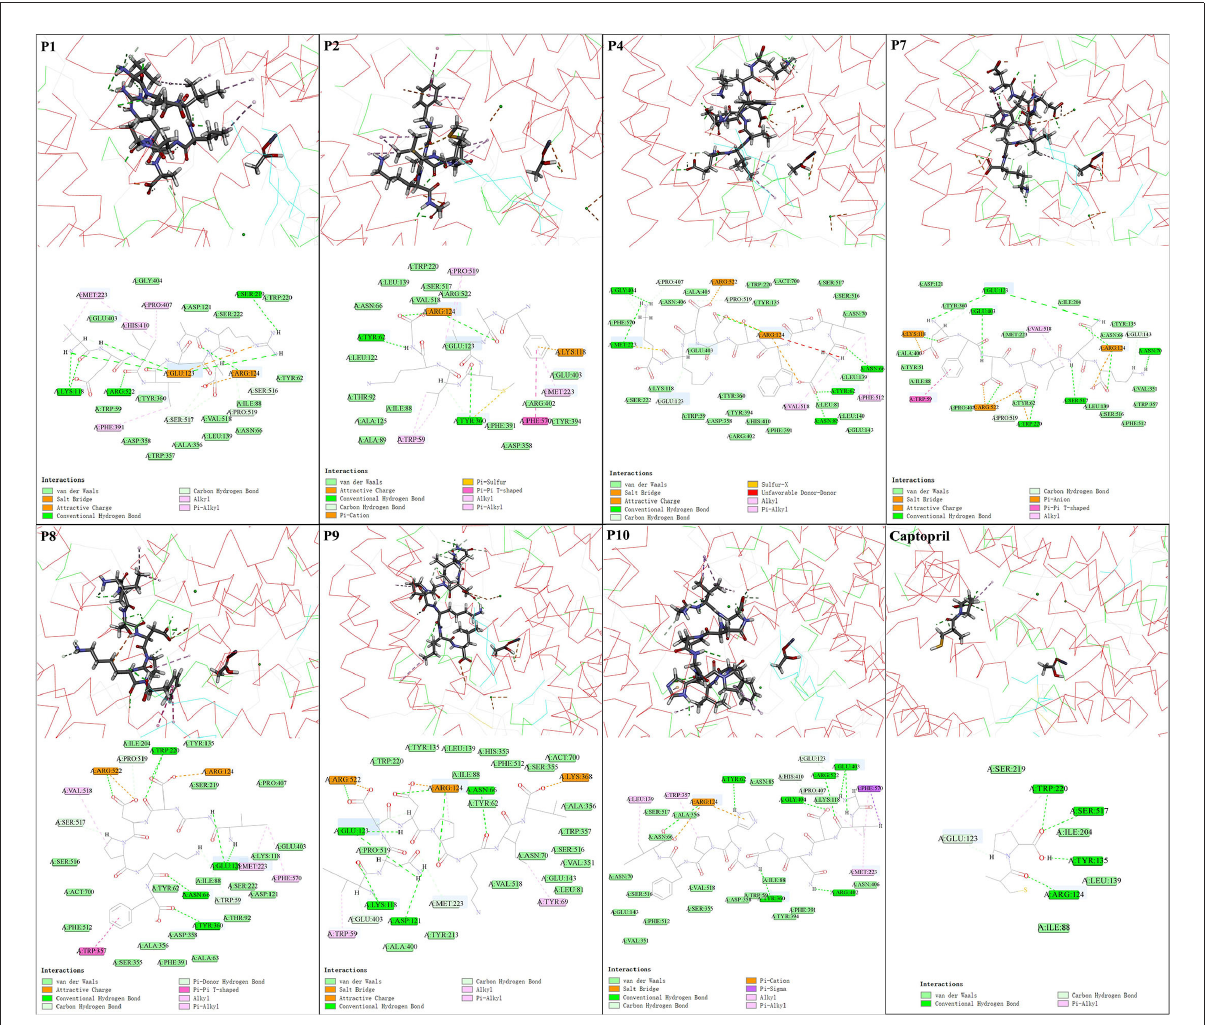
FIGURE3 Molecular interactions of the core ACE inhibitory peptides (P1, P2, P4, P7, P8, P9, and P10) and captopril into the active site of